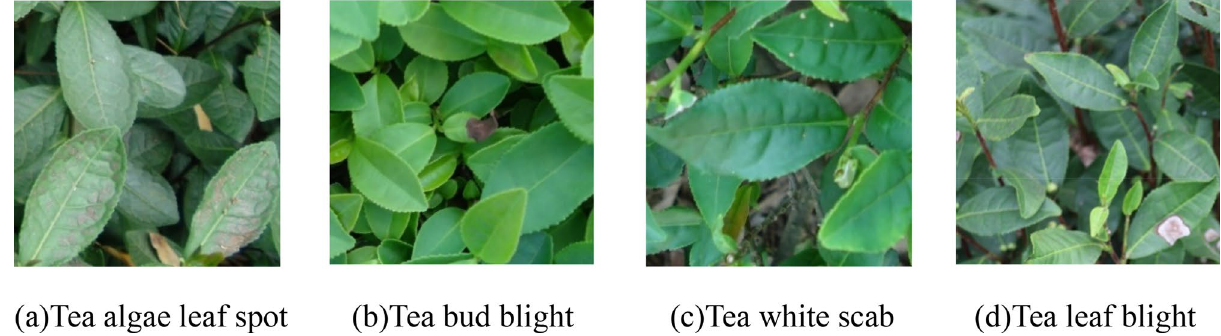
Figure 1. Examples of captured tea images of four tea leaf’s